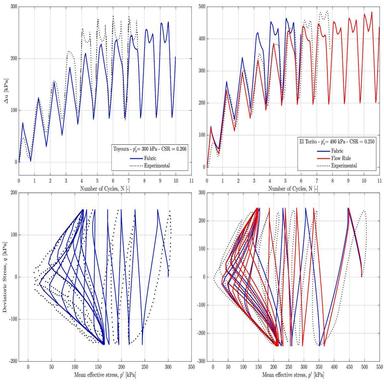
Excess of pore water pressure build-up and effective stress paths for Toyoura sand (left), and El Torito tailings sand (right).